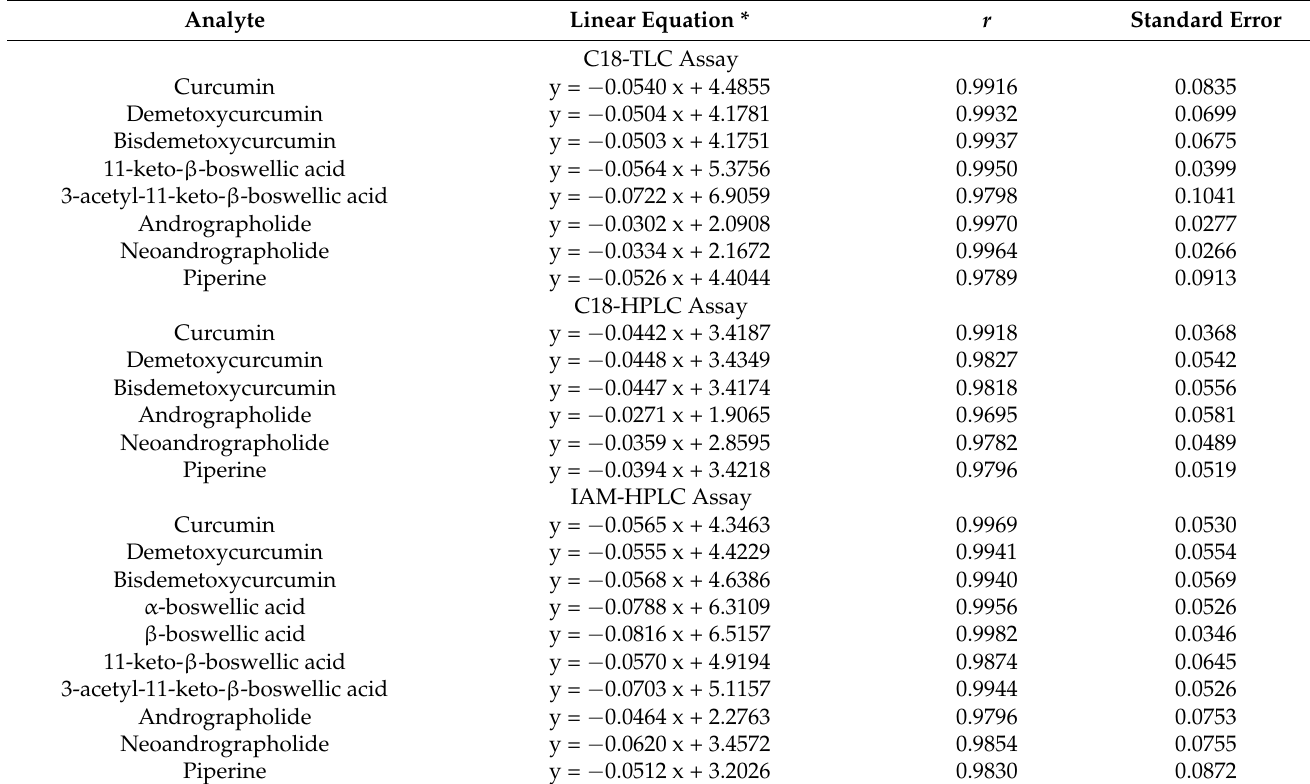
Table 4. Hydrophobicity and lipophilicity parameters determined by chromatographic